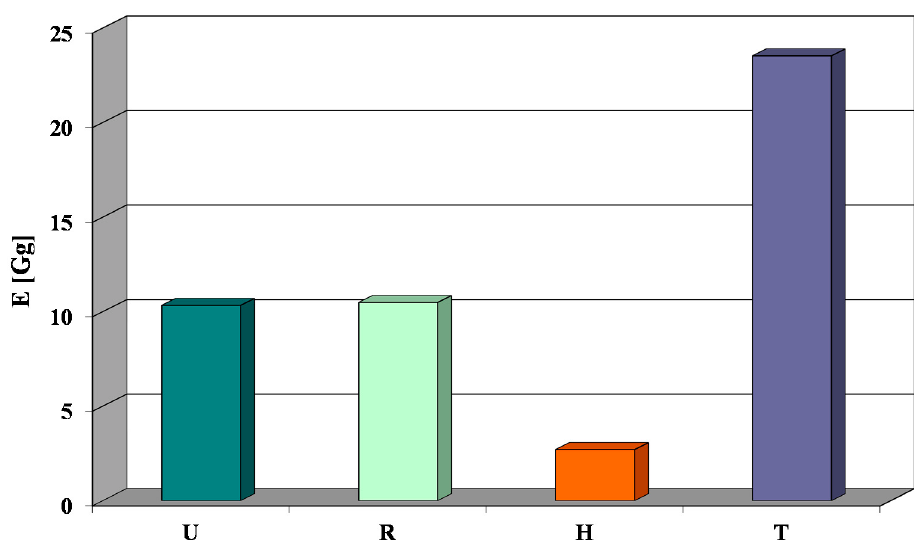
Figure 7. National annual emissions (E) of total suspended particles (TSP-T) from road transport under different traffic conditions: urban (U), rural (R), highway (H) and total (T).